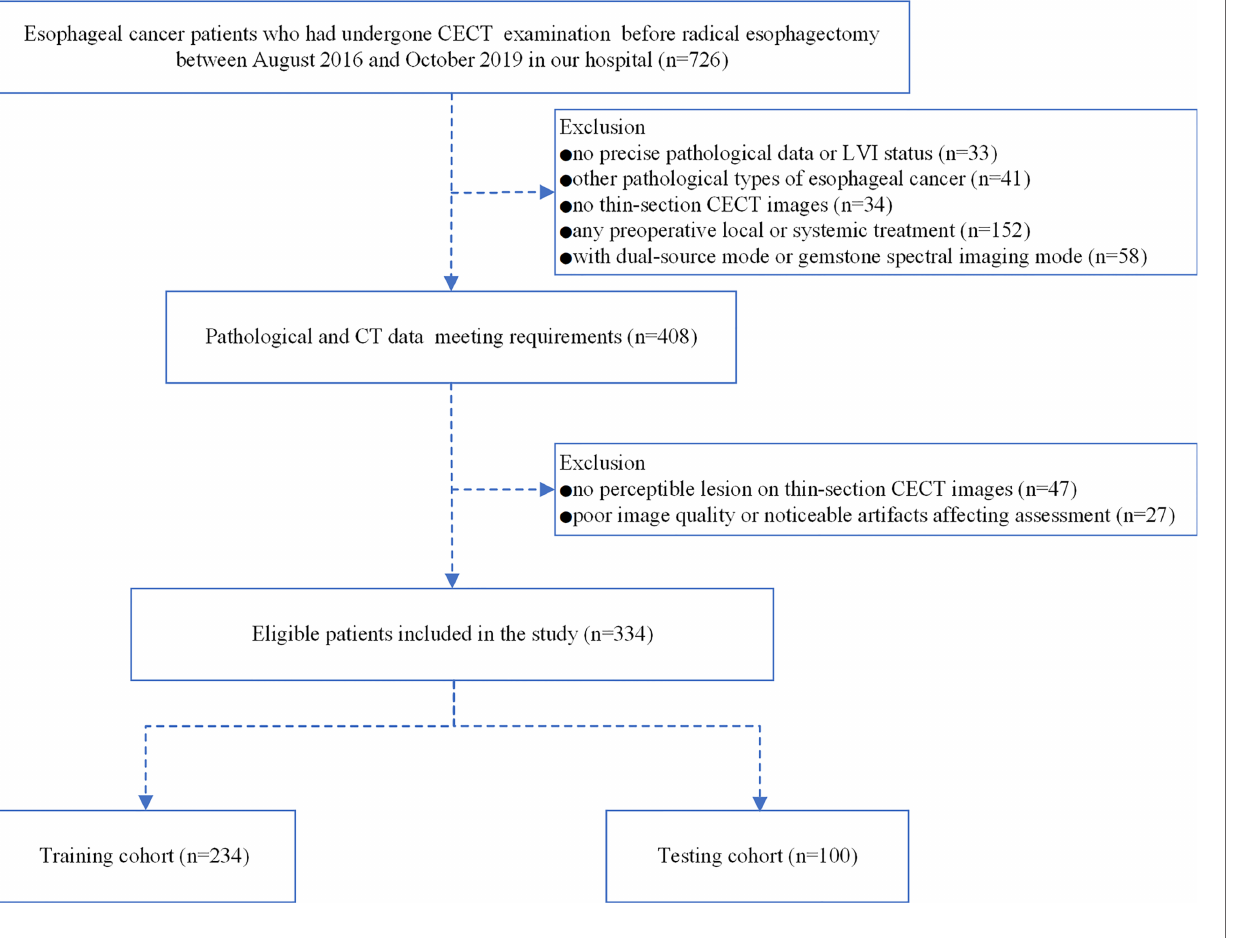
FIGURE 1 | Flow chart illustrating the patient selection and exclusion